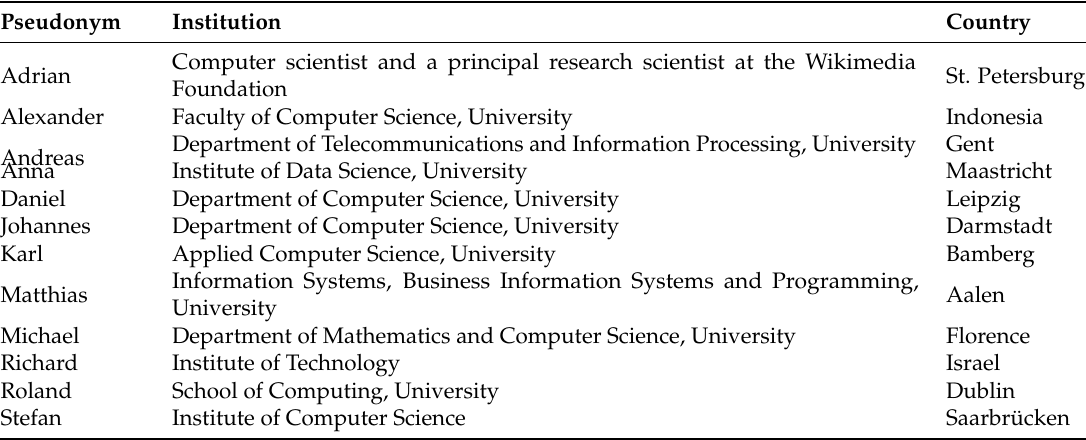
Table 1. Pseudonyms, institutions and countries of the